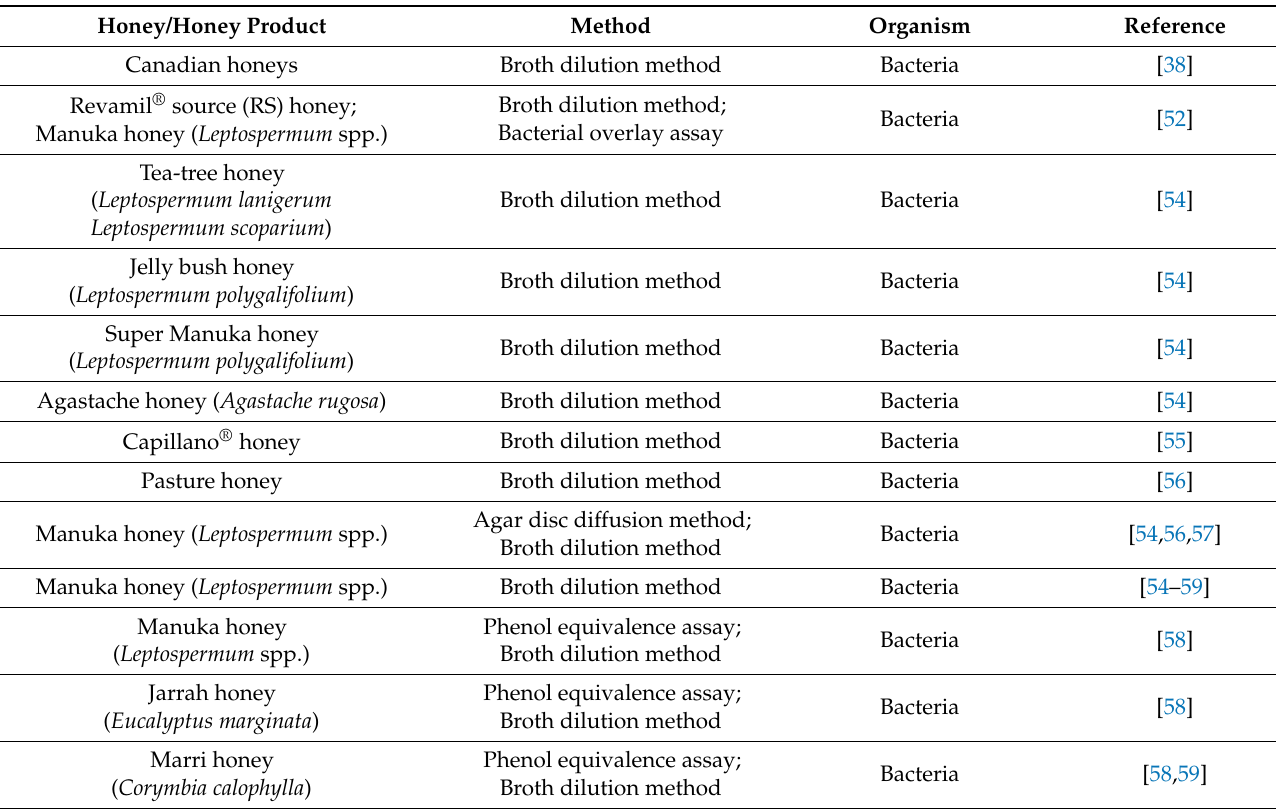
Table 1. Methodologies used for the determination of antimicrobial activity of honey and honey